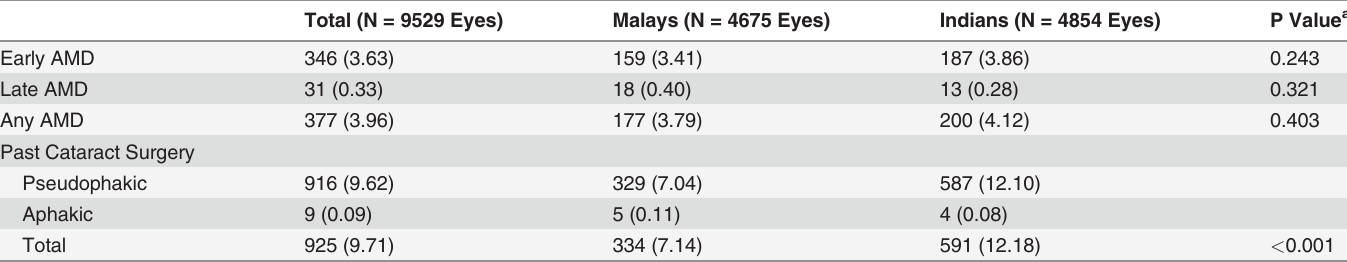
Table 2. Distribution of AMD and cataract surgeries by ethnicity.